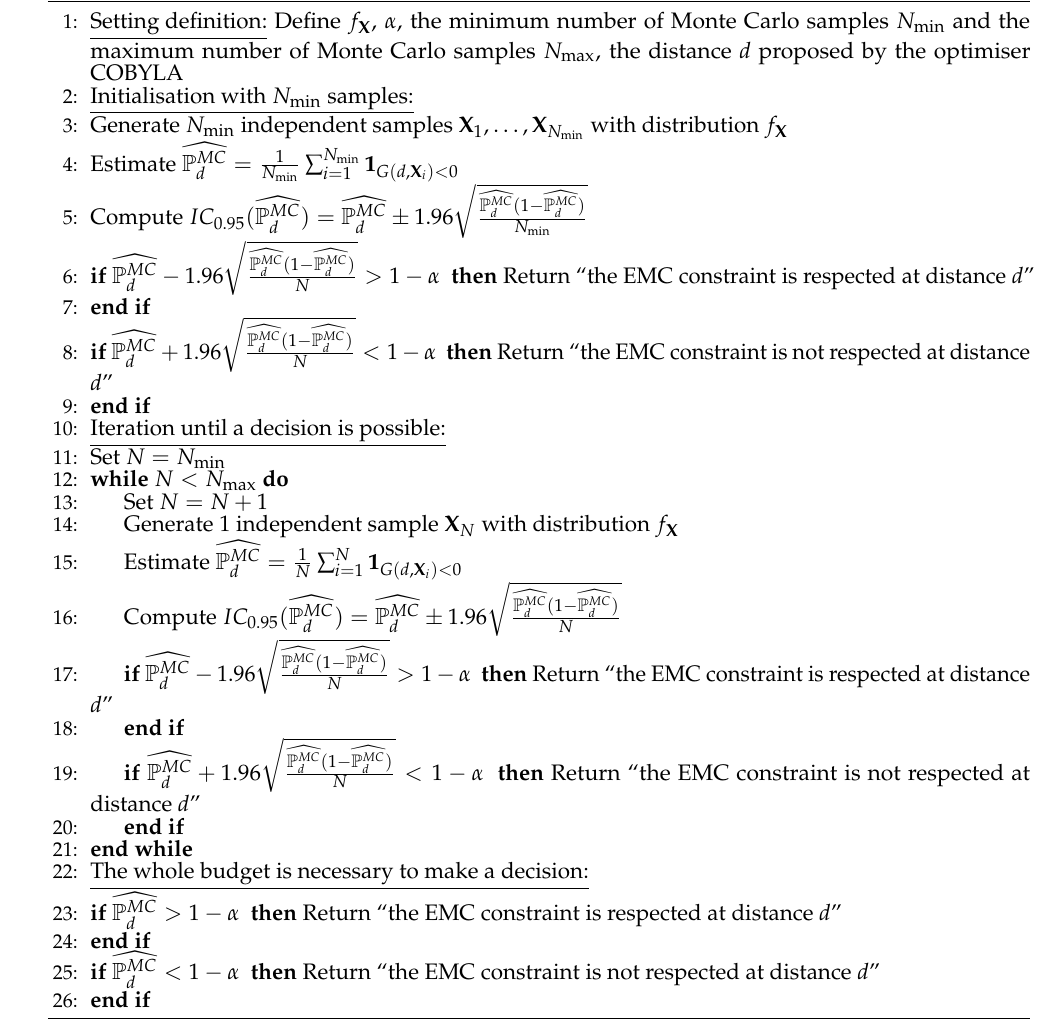
Algorithm A1 EMC probability evaluation with the Monte Carlo